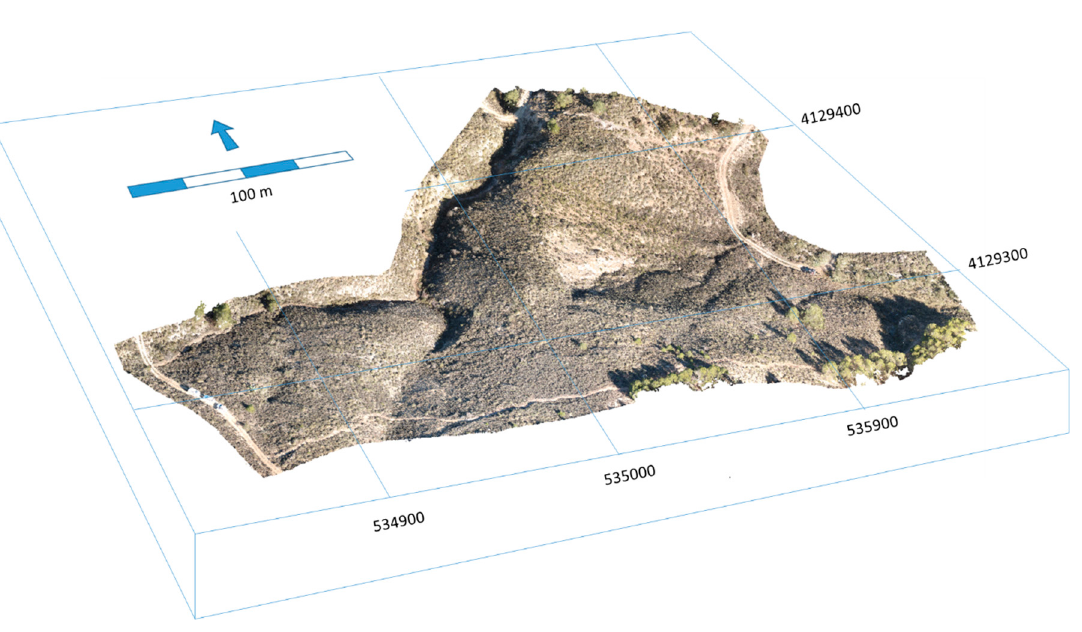
Figure 7. Perspective view of the dense point cloud, centred in the study area and represented as an RGB composite.